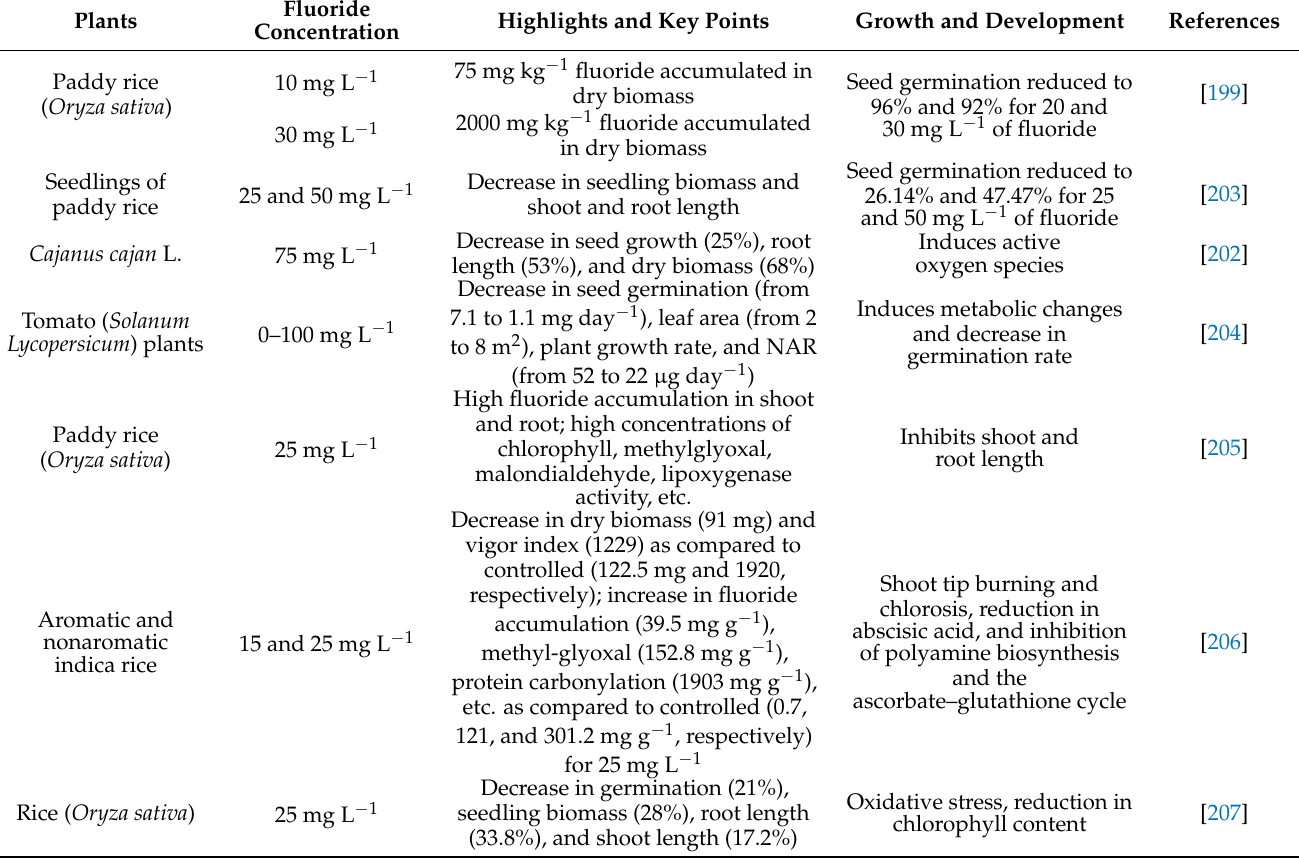
Table 1. Impacts of fluoride uptake and accumulation on plants and their physiological